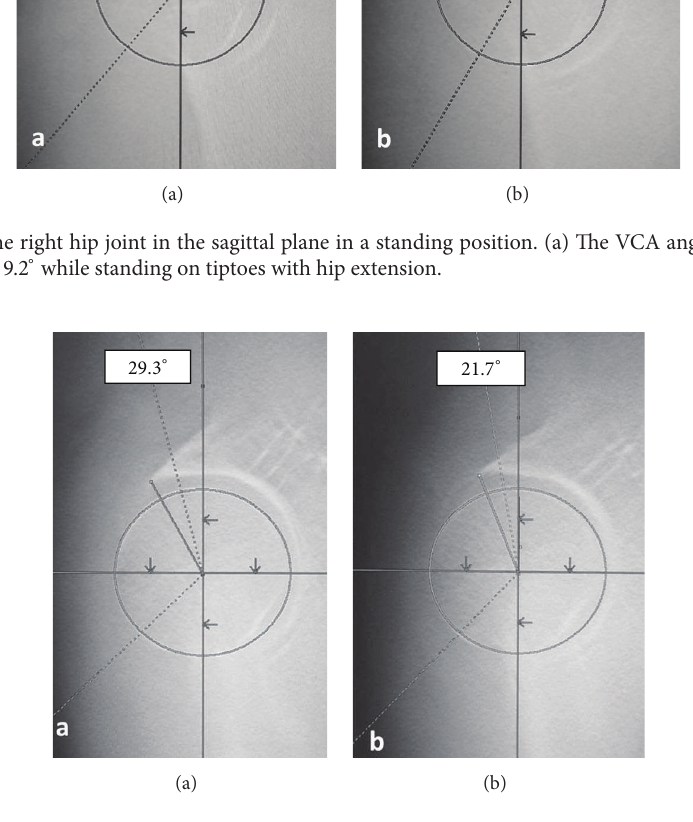
Figure 5: Tomosynthesis of the left hip joint in the sagittal plane in a standing position. (a) The VCA angle is 29.3 ∘ in a natural standing position. (b) The VCA angle is 21.7 ∘ while standing on tiptoes with hip